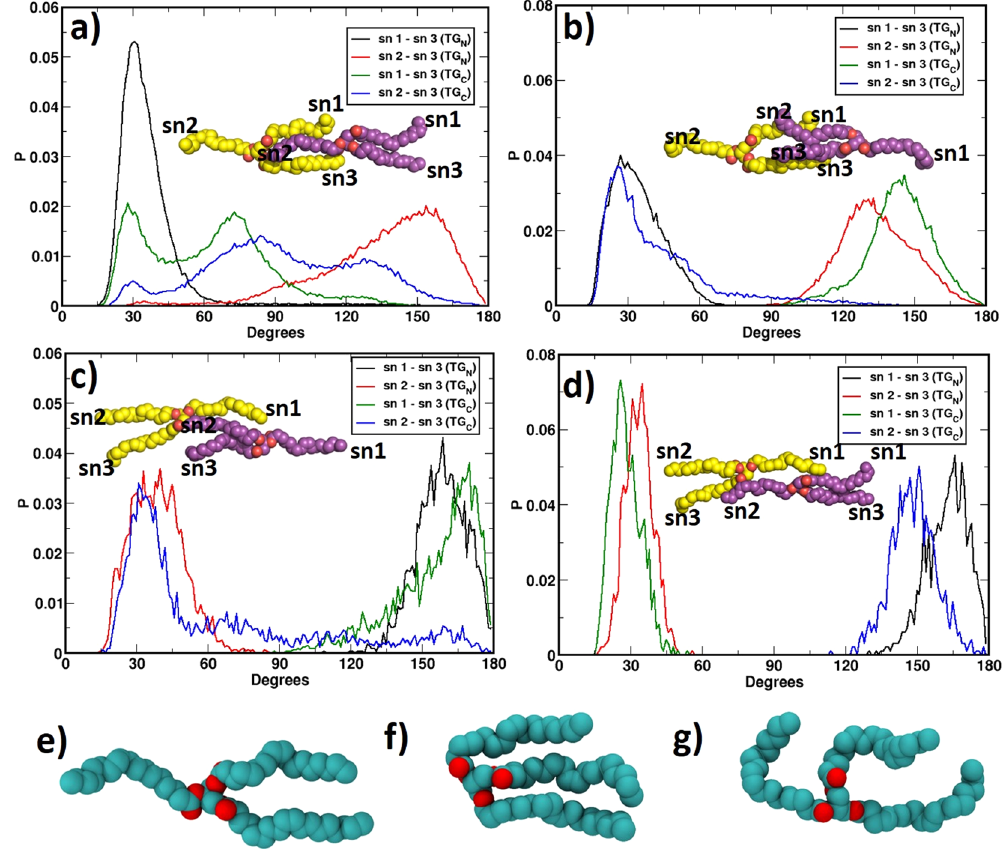
Figure 3. Distribution of angles between the three oleate chains, sn1, sn2, sn3 of both TGs from UA simulation data. Results are shown for bound TGs in CETP with ( a ) “parallel N-N” orientation, ( b ) “antiparallel N-C” orientation, ( c ) “parallel C-C” orientation, and ( d ) “antiparallel C-N” orientation. The color codes of the graphs are included in insets. Initial TG conformations (TG N : yellow, TG C : purple) are shown for easy understanding. Different conformations of TG C observed during simulation of system-I are shown: ( e ) tuning fork, ( f ) trident, and ( g )